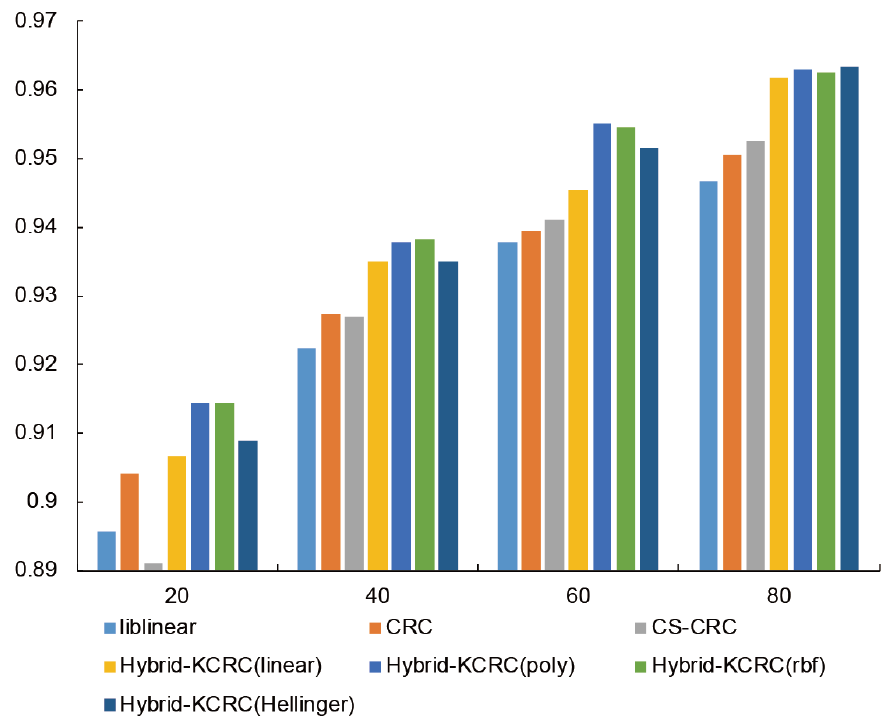
Figure 4. Classification rate on UC-Merced dataset with different number of training samples in each